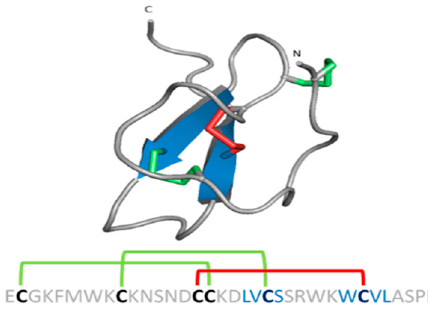
Figure 9. ICK scaffold in peptide gating modifiers. Sequence and structure of the VsTx1 toxin. Disulfide bridge ring is shown in green.